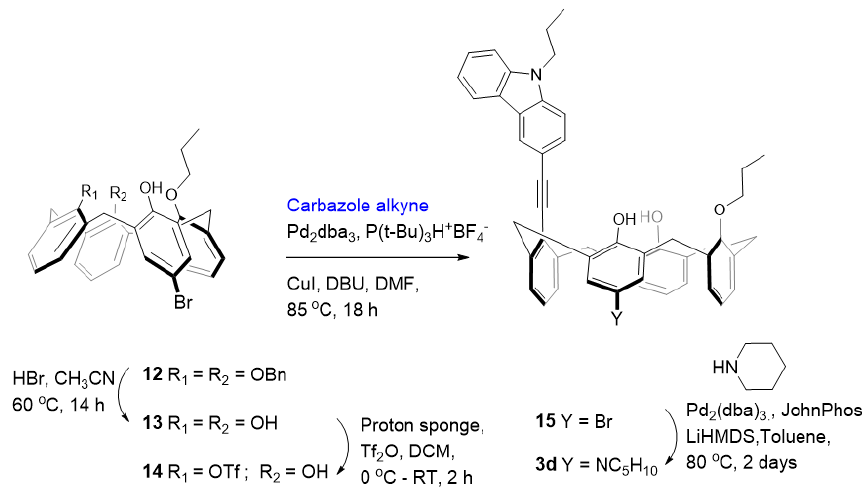
Figure 3. Absorbance–emission spectra of compounds 3a – d